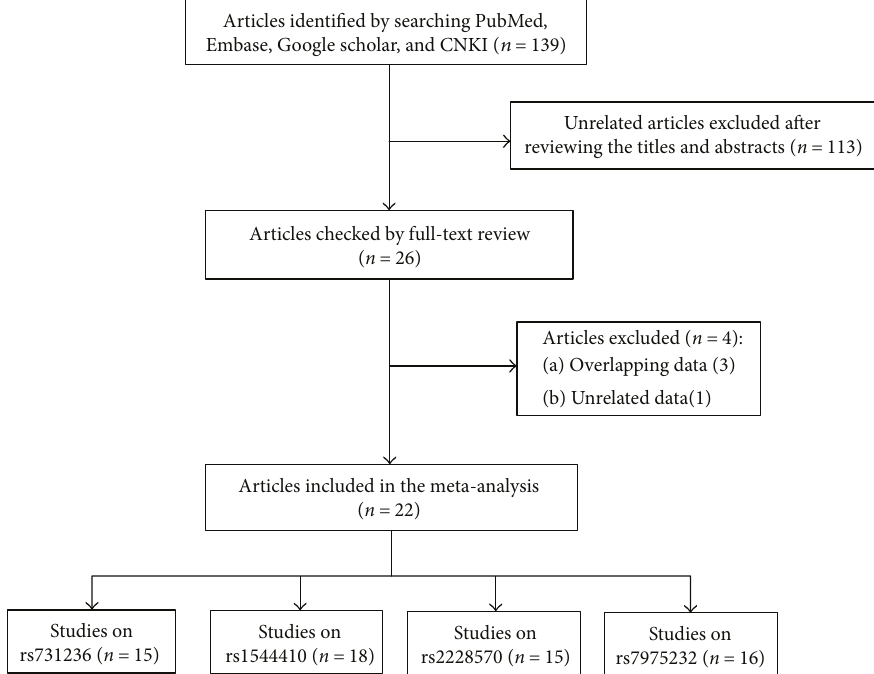
Figure 1: The fl owchart for identifying eligible